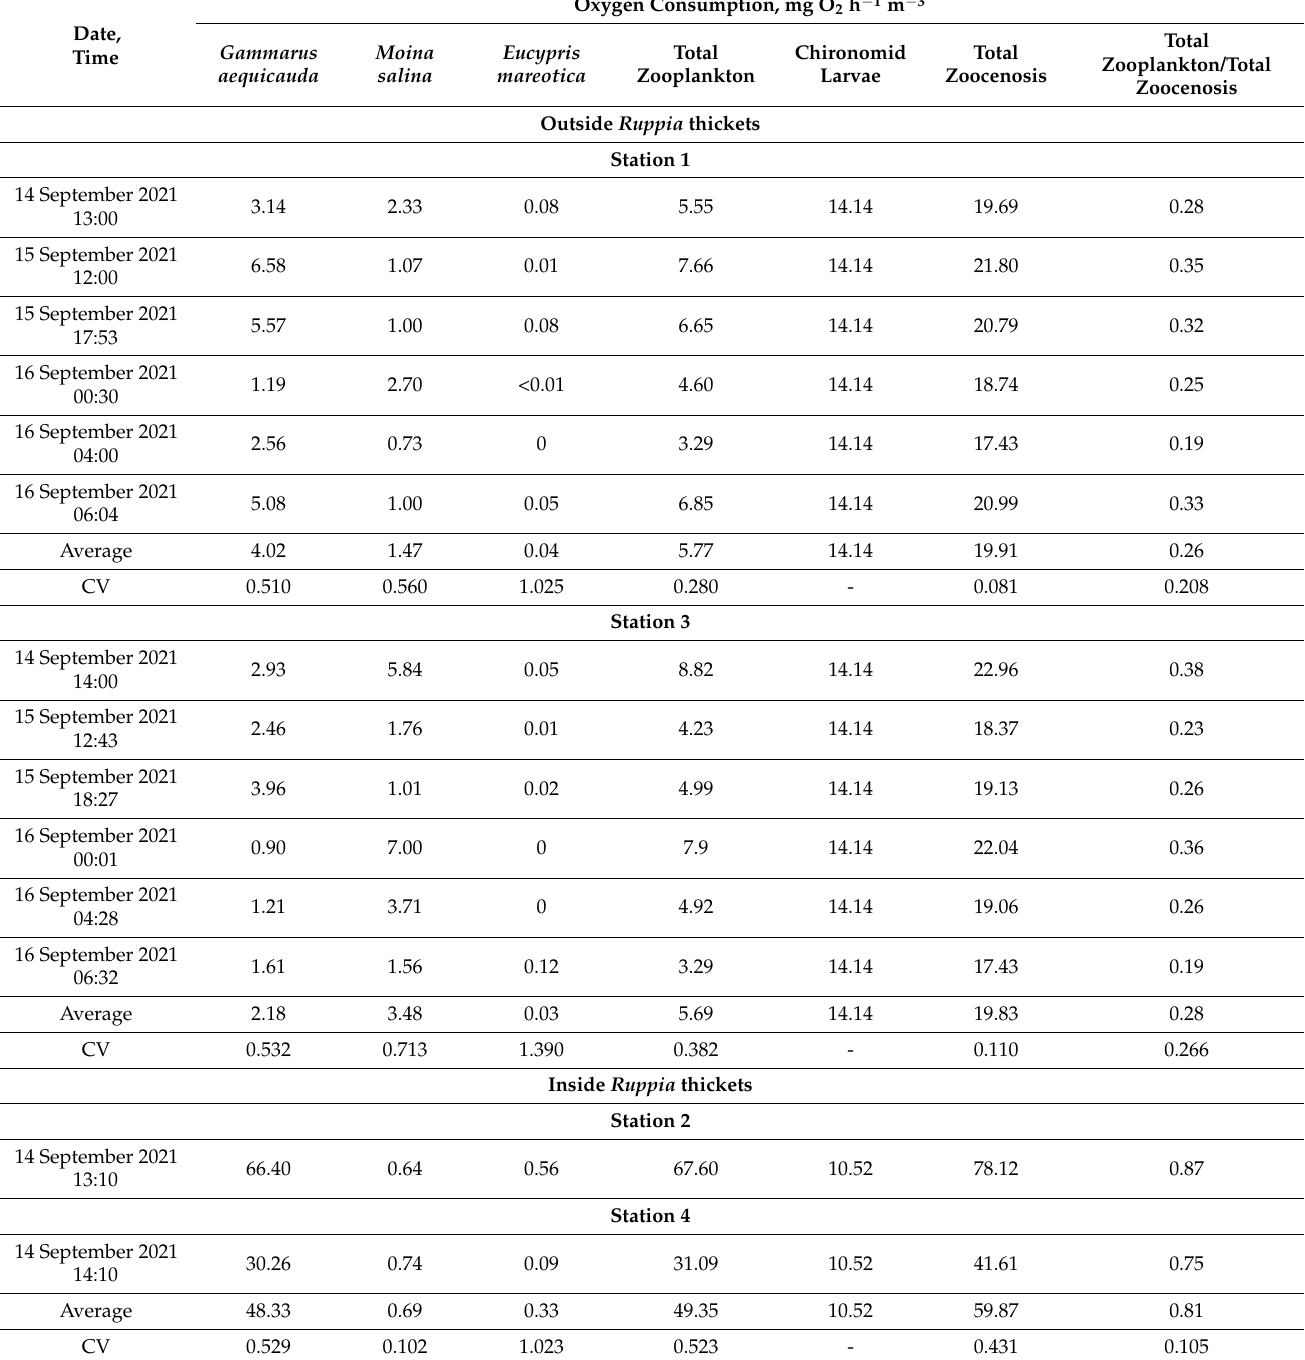
Table 1. Calculated indicators of oxygen consumption by zoocenosis in Lake Moynaki, 15–16 September